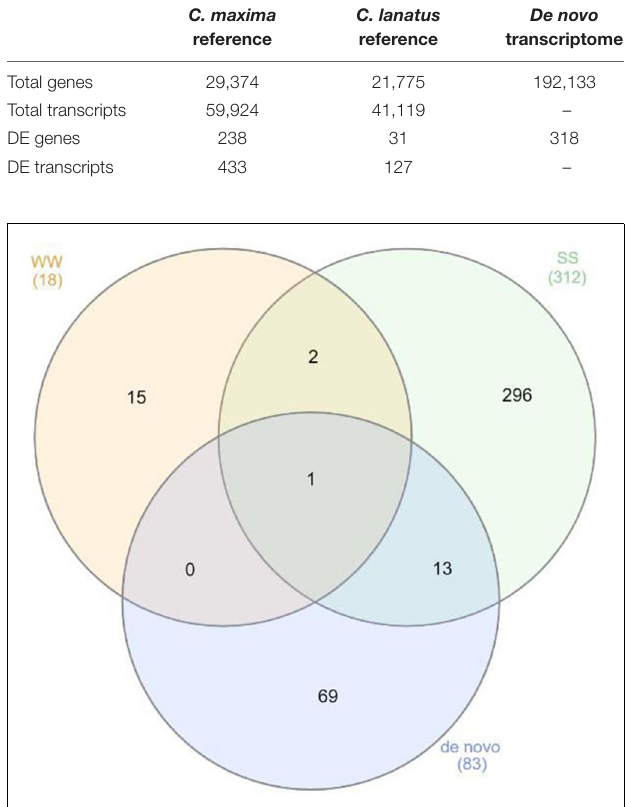
FIGURE 3 | Venn diagram depicting the gene ontologies found to be differentially expressed (DE) among the three